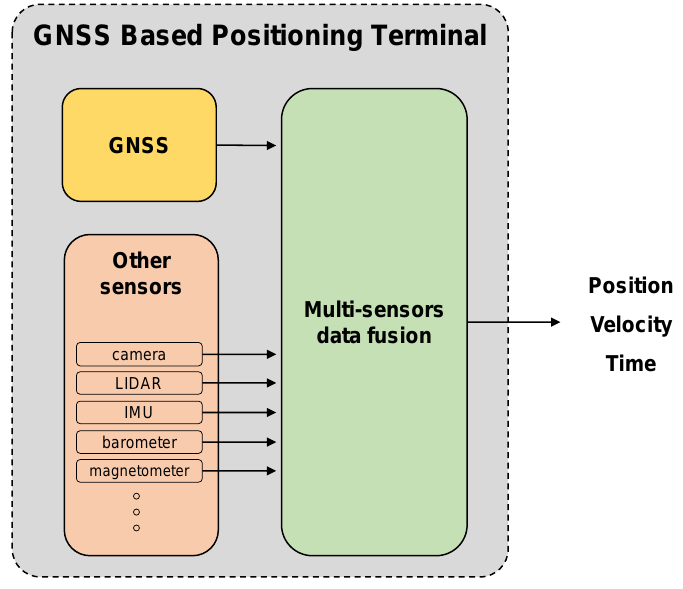
Figure 1. Global navigation satellite systems (GNSS)-based positioning terminal (GBPT) system architecture. IMU: inertial measurement unit.